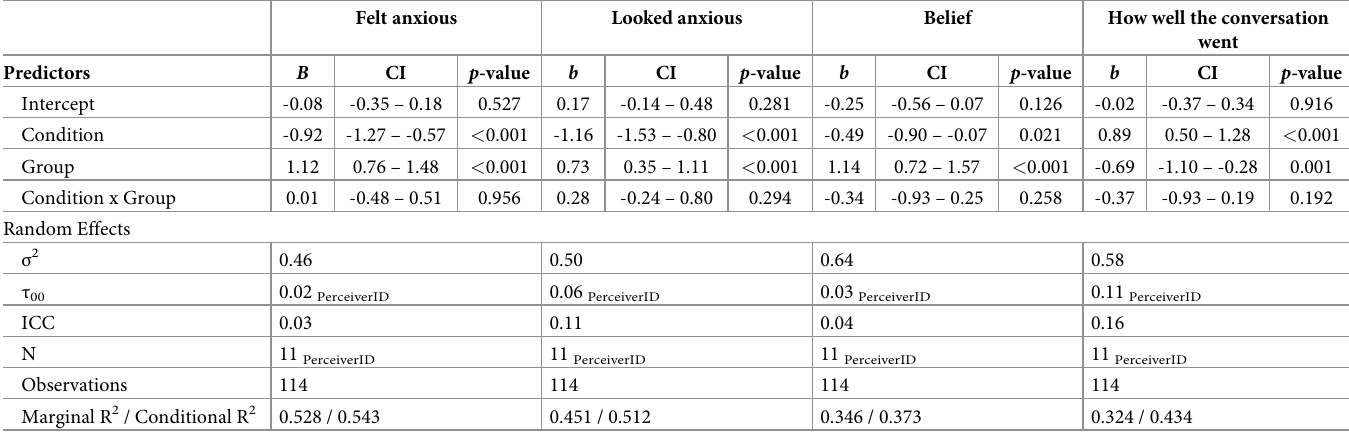
Table 4. Linear mixed model results for self-report